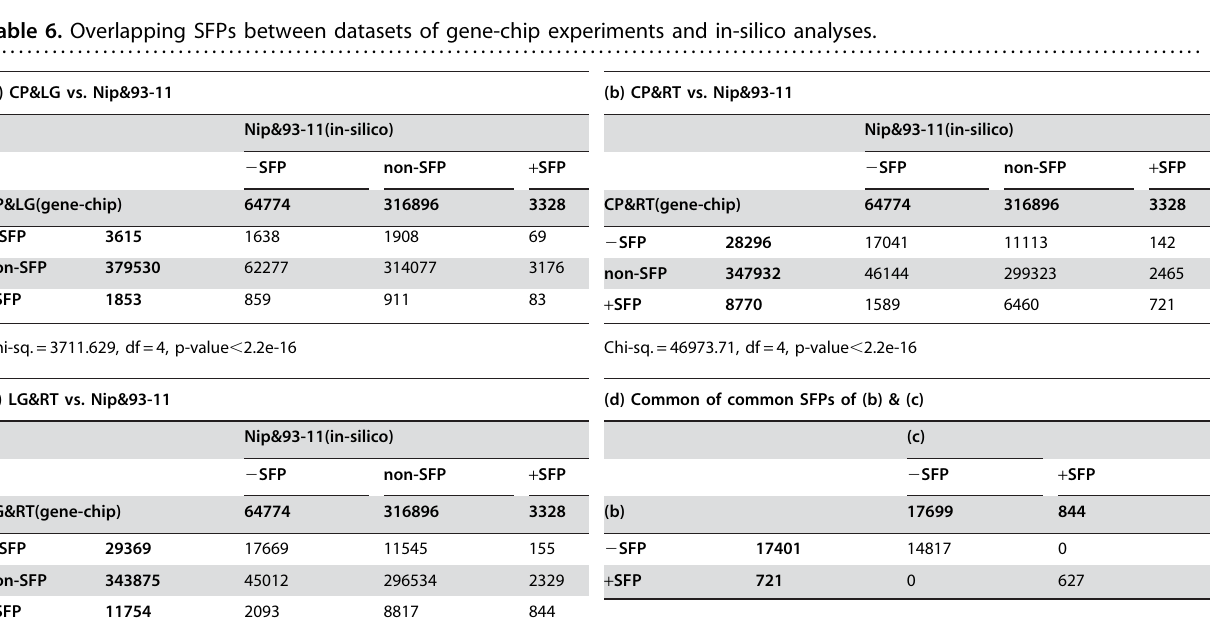
The SFPs data have been taken from estimated FDR (delta) of 11.9% (delta=2) in CP&LG, 10% (delta=2) in CP&RT and 10% (delta=1.6) in LG&RT respectively. The sign ( + / 2 ) indicates direction of polymorphism as explained in Figure-3 legend. CP=Cypress, LG=LaGrue and RT=RT0034. doi:10.1371/journal.pone.0000284.t005 In gene-chip predicted SFPs comparison study in japonica&indica datasets combination , . 70% of the total polymorphic SFP were common (Table 5b). This contrast with , 30% of common SFPs observed in gene-chip vs. in-silico studies in two different japonica&indica datasets combination (Table 6b&c). The above discrepancy could be because (a) both japonica & indica varieties were different (b) in-silico predicted SFPs has significantly less number of + SFP compared to 2 SFP (supplementary Table S3) possibly because of the criteria used to predict + SFP (see methods; In silico SFP analyses) and (c) only 384998 features shared by in- silico and gene-chip were considered instead of , 630000 features considered in only gene-chip predicted SFP comparison study.